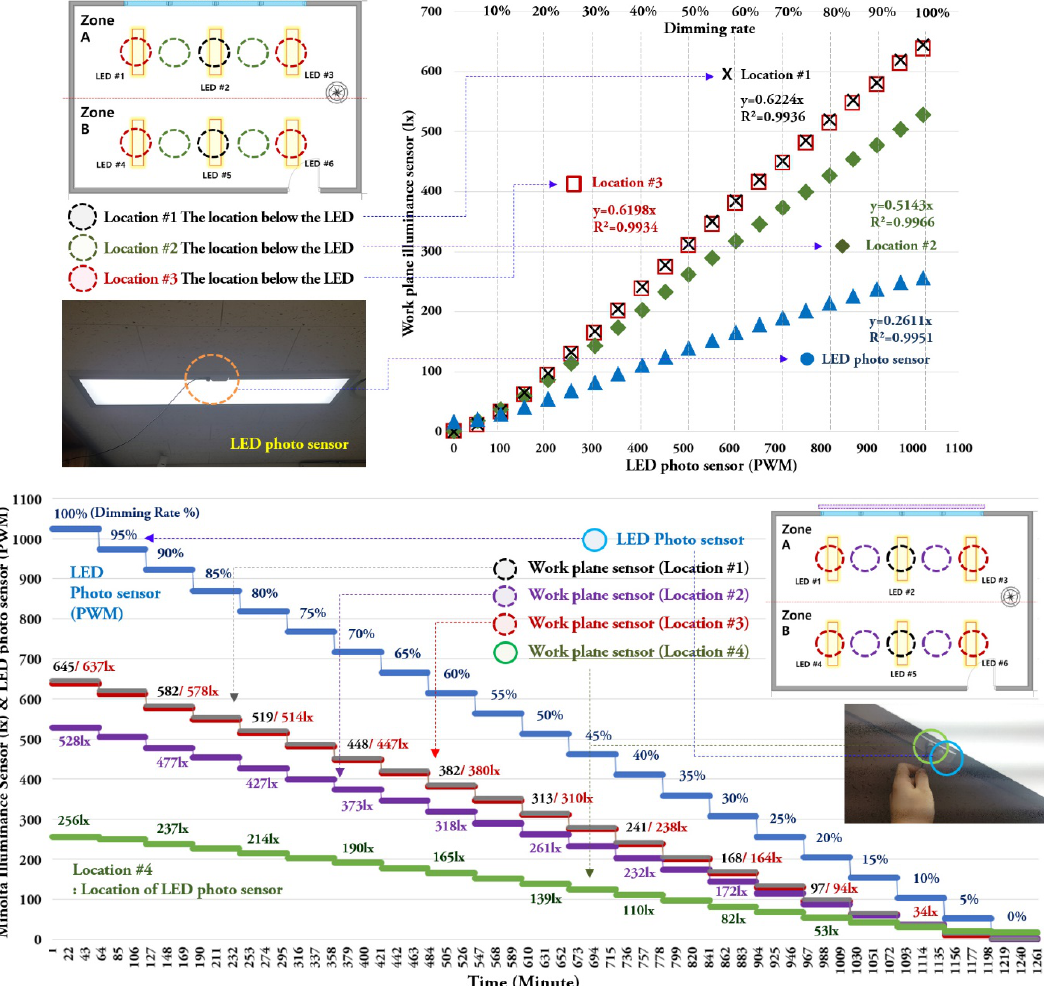
Figure 11. Calibration of the work plane illuminometers and LED photo sensor